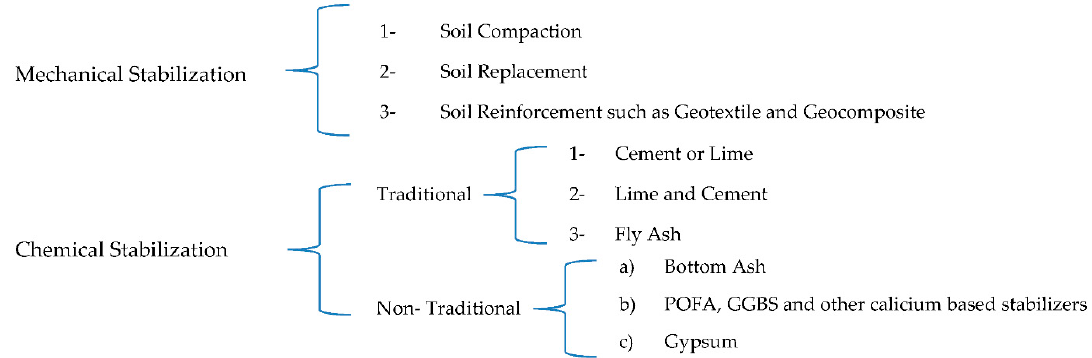
Figure 1. Expansive soil’s stabilizing methods.